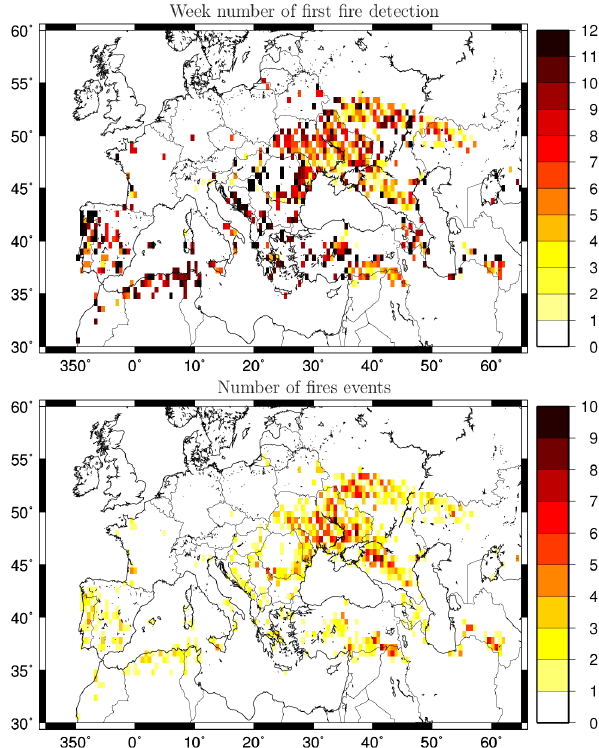
Figure 6. Synthesis of vegetation fires events observed during the summer of 2013, from the 1 June to the 31 August. [top] week of first detection, [bottom] number of